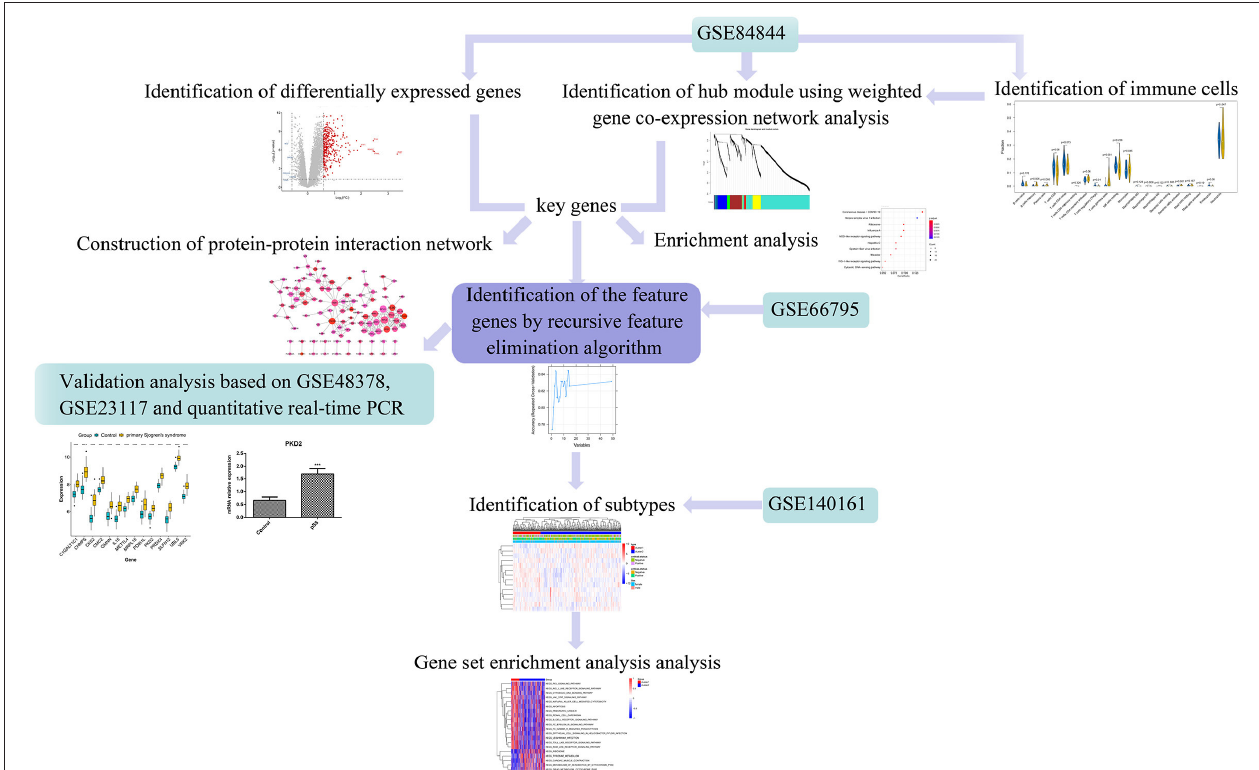
FIGURE 1 | Workflow of this study. Differentially expressed genes (DEGs) were screened based on the gene expression profiles obtained from the Gene Expression Omnibus (GEO) database. The differences in respective immune cell proportions between control and diseased tissues were compared. Weighted gene co-expression network analysis (WGCNA) was performed to identify the key modules, followed by a protein-protein interaction (PPI) network generation and enrichment analysis. The feature genes were screened using the recursive feature elimination algorithm and verified using the GEO datasets and quantitative real-time PCR (RT-qPCR).